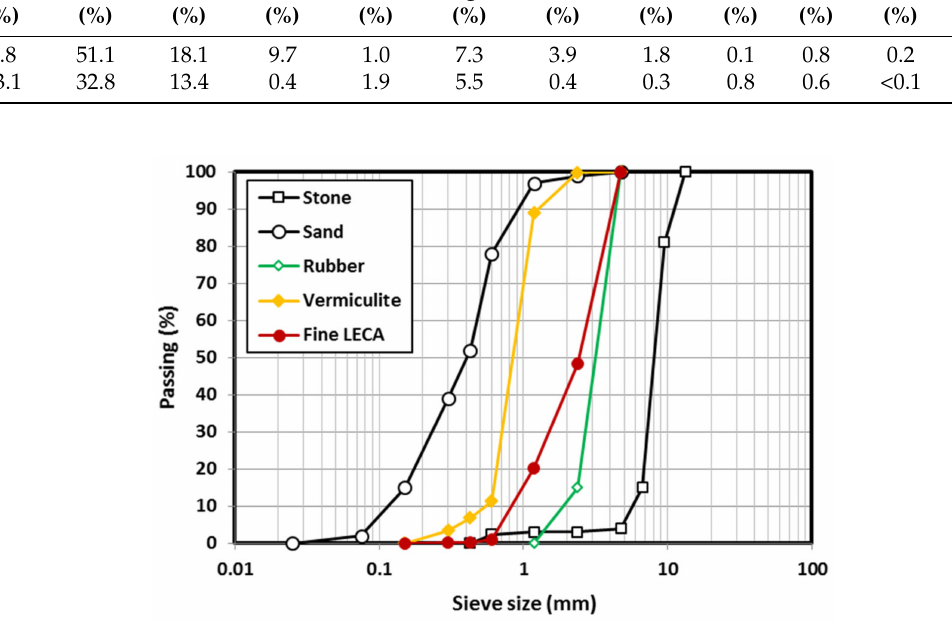
Figure 1. Particle size distribution for all aggregates